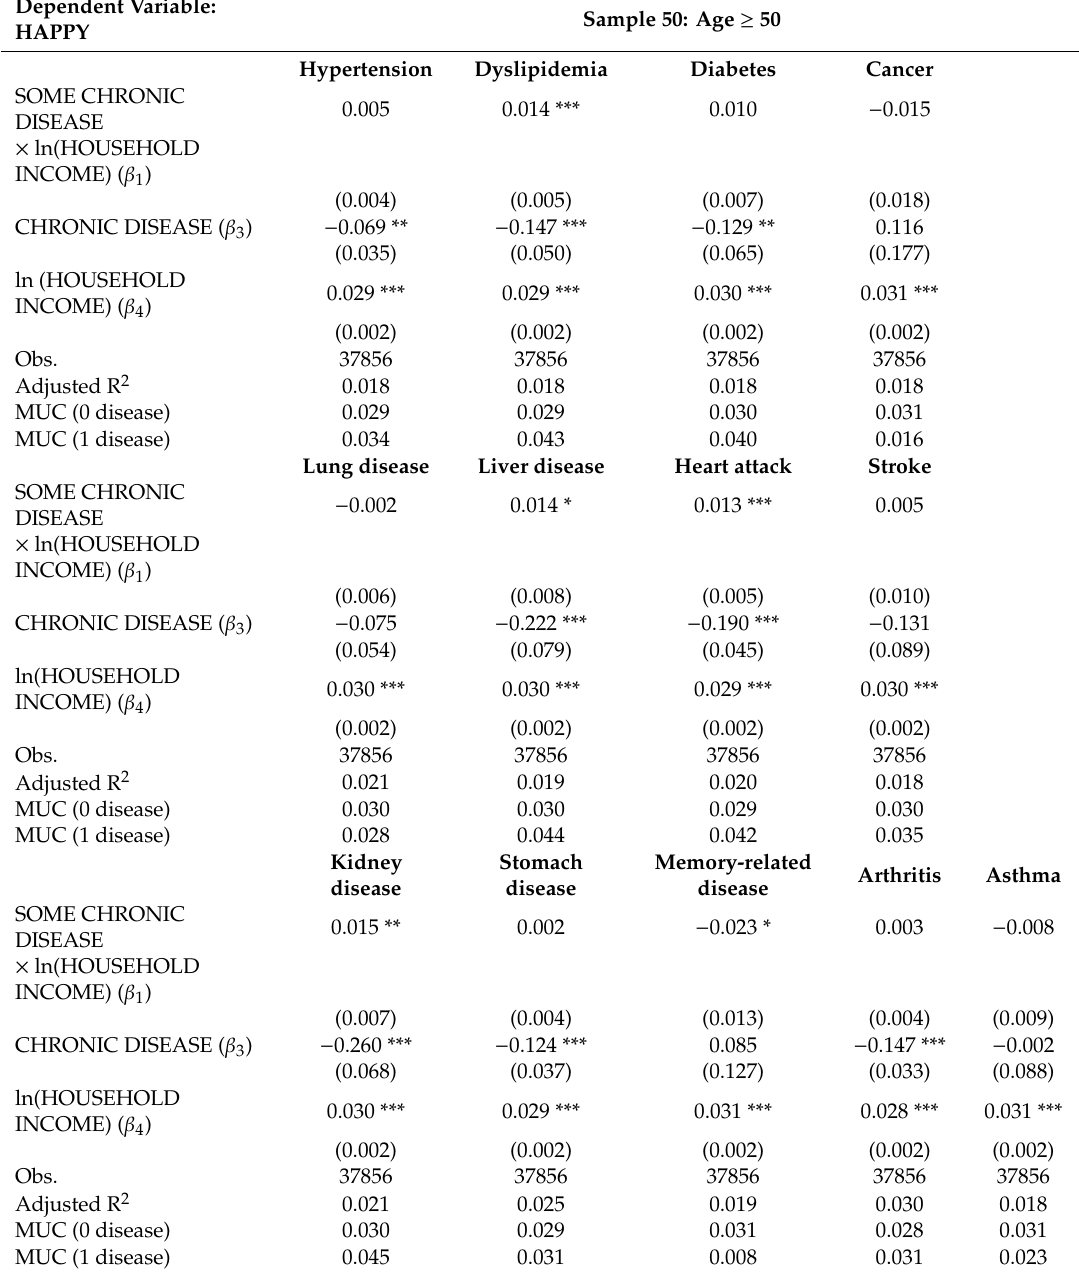
Table 5. E ff ect of a chronic disease on marginal utility of consumption (Sample